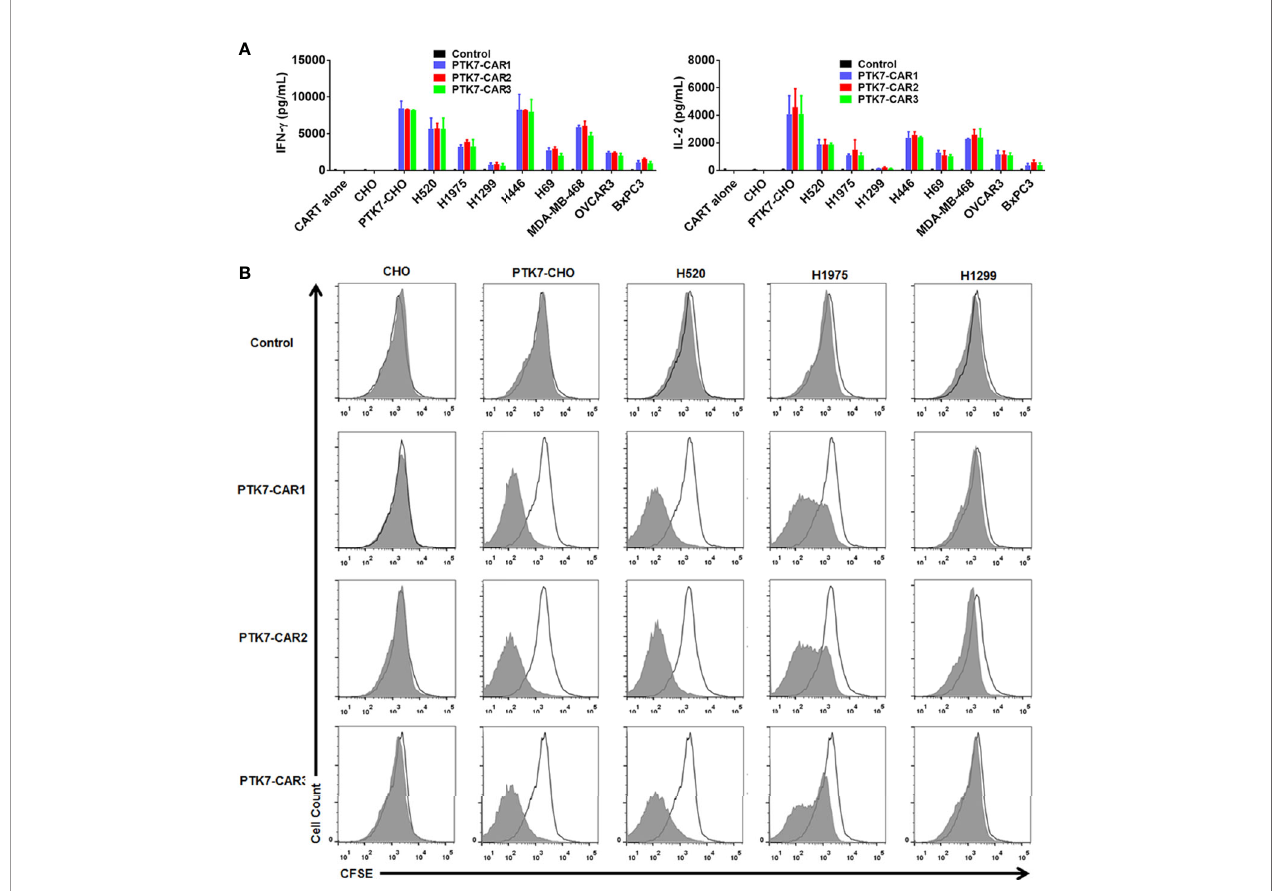
FIGURE 3 | PTK7-CAR T cells release IFN- g and IL-2 and proliferate in response to PTK7-positive target cells. (A) Control or PTK7-CAR T cells from healthy donors (n = 3) were co-cultured with CHO and PTK7-CHO and various PTK7-expressing tumor cell lines for 24 h before performing IFN- g and IL-2 ELISA. Mean and SEM are shown. (B) T cells were labeled with CFSE and co-cultured for 3 days with CHO, PTK7-CHO, H520, H1975, or H1299 cells in the absence of exogenous IL-2, and CFSE dilution was analyzed by fl ow cytometry. A representative histogram from three independent assays is